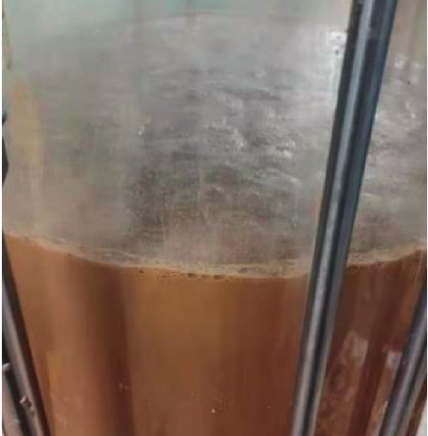
Figure 6: Displacement-time curves for soil consolidation settlement.